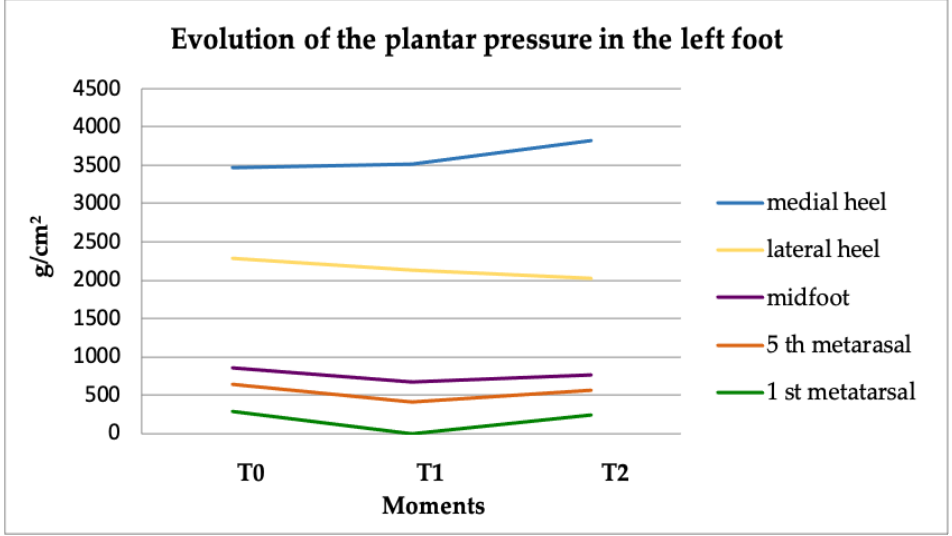
Figure 3. Evolution of plantar pressure in the left foot. Statistically significant data were found for the variations of pressure values at the internal side of the left foot: left 1st metatarsal area ( p = 0.01) and medial left heel ( p = 0.006) at T2 (Table 2). Table 2. The values of pressure recorded from the sole in the left foot (opposite side as the occlusal imbalance) .